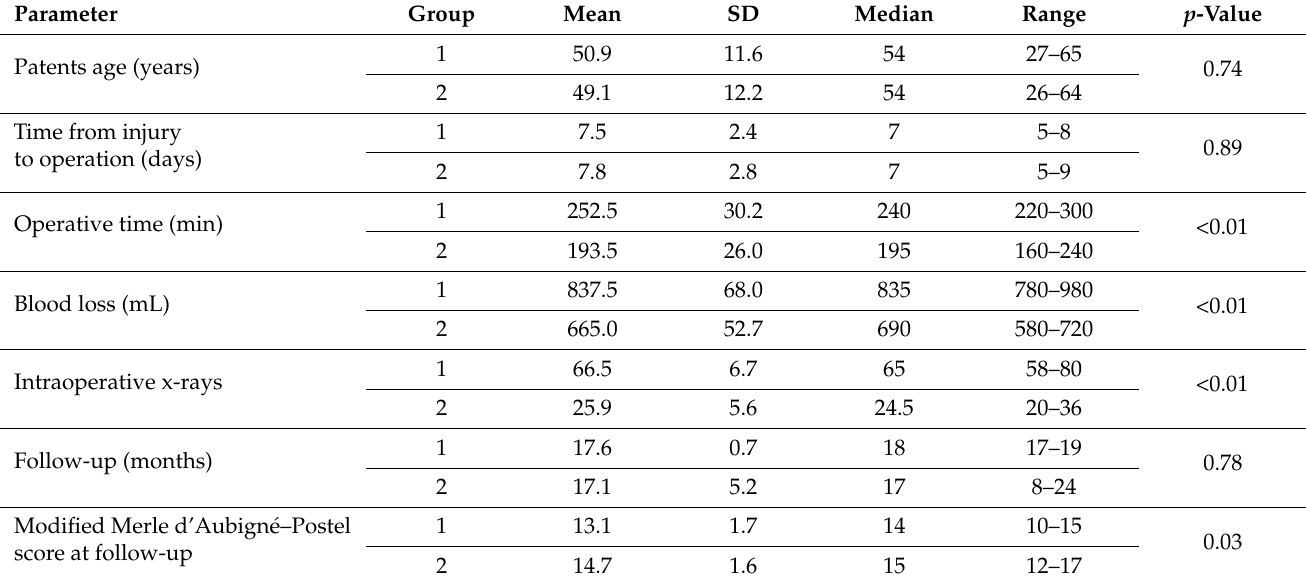
Table 2. Parameters of interest between groups 1 (conventional) and 2 (3D printed) in terms of mean value, standard deviation (SD), median, and range, together with the corresponding p